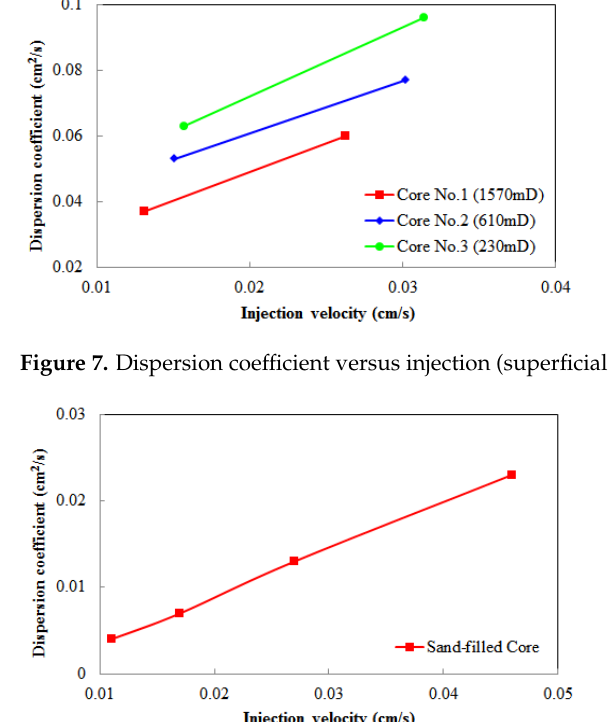
Figure 9. Schematic diagram of structures of porous media: ( a ) small pore sizes, ( b ) large pore sizes.